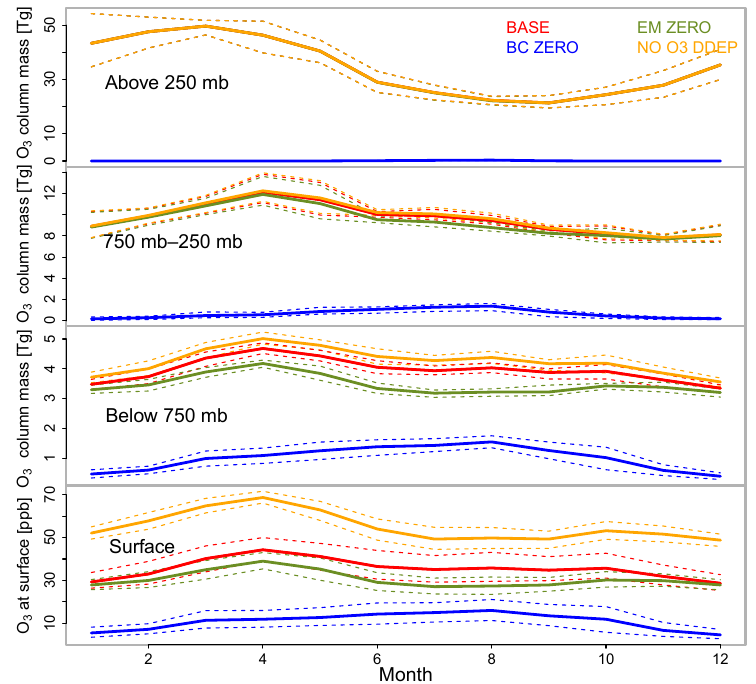
Figure 6. The upper three panels present time series of the monthly average domain-total ozone column mass for the BASE, BC ZERO, EM ZERO, and NO O3 DDEP sensitivity simulations for the same three layer ranges analyzed in Fig. 5 while the lowest panel presents time series of monthly average domain-average ozone mixing ratios for the first model layer. The dashed lines represent the 5th and 95th percentiles of the hourly domain-total ozone column mass and domain-average ozone mixing ratios for a given